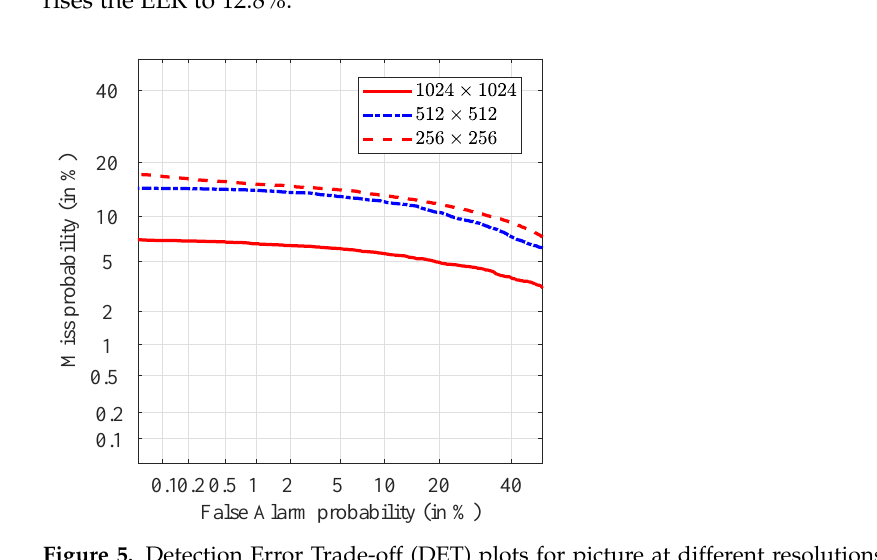
Figure 5. Detection Error Trade-off (DET) plots for picture at different resolutions: 1024 × 1024, 512 × 512 and 256 × 256.